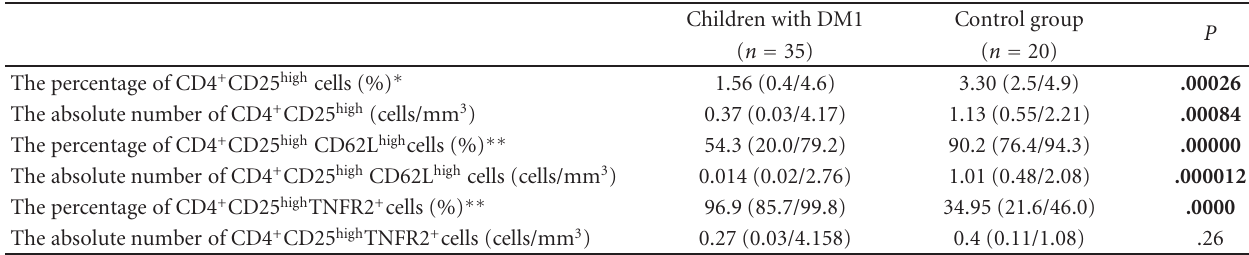
Table 2: The percentage and number of CD4 + CD25 high , CD4 + CD25 high CD62L high , and CD4 + CD25 high TNFR2 + T cells.